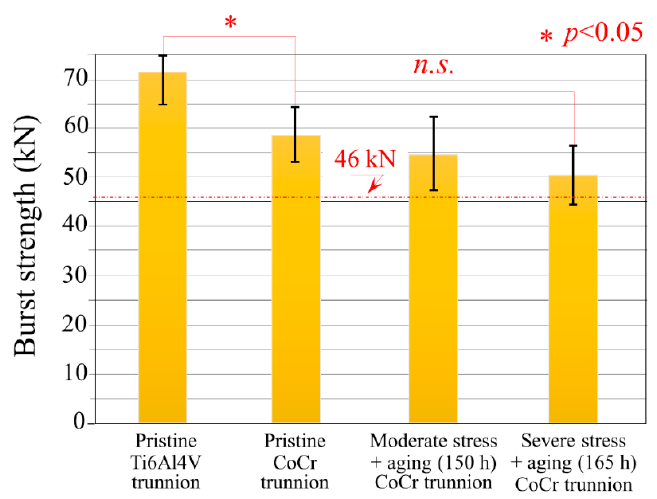
Figure 2. Burst-strength results obtained on the different series of samples.